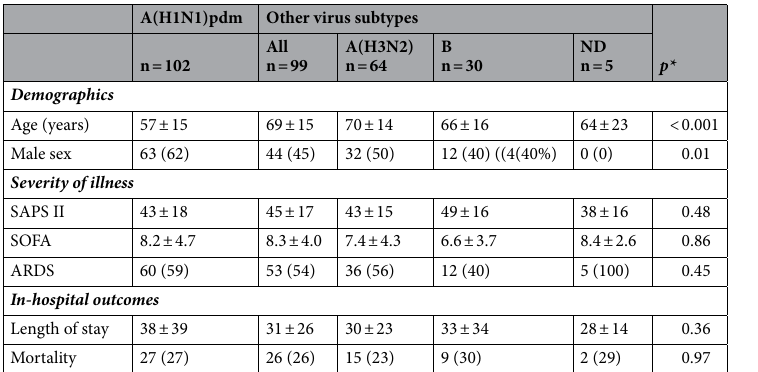
Table 3. Clinical data and outcomes according to virus subtype. Data are number (%) or mean ± standard deviation, as appropriate. ND: Not documented; SAPS II: Simplified Acute Physiology Score II; SOFA: Sepsis- Related Organ Failure Assessment; ARDS: Acute Respiratory Distress Syndrome. *A(H1N1)pdm versus all other virus